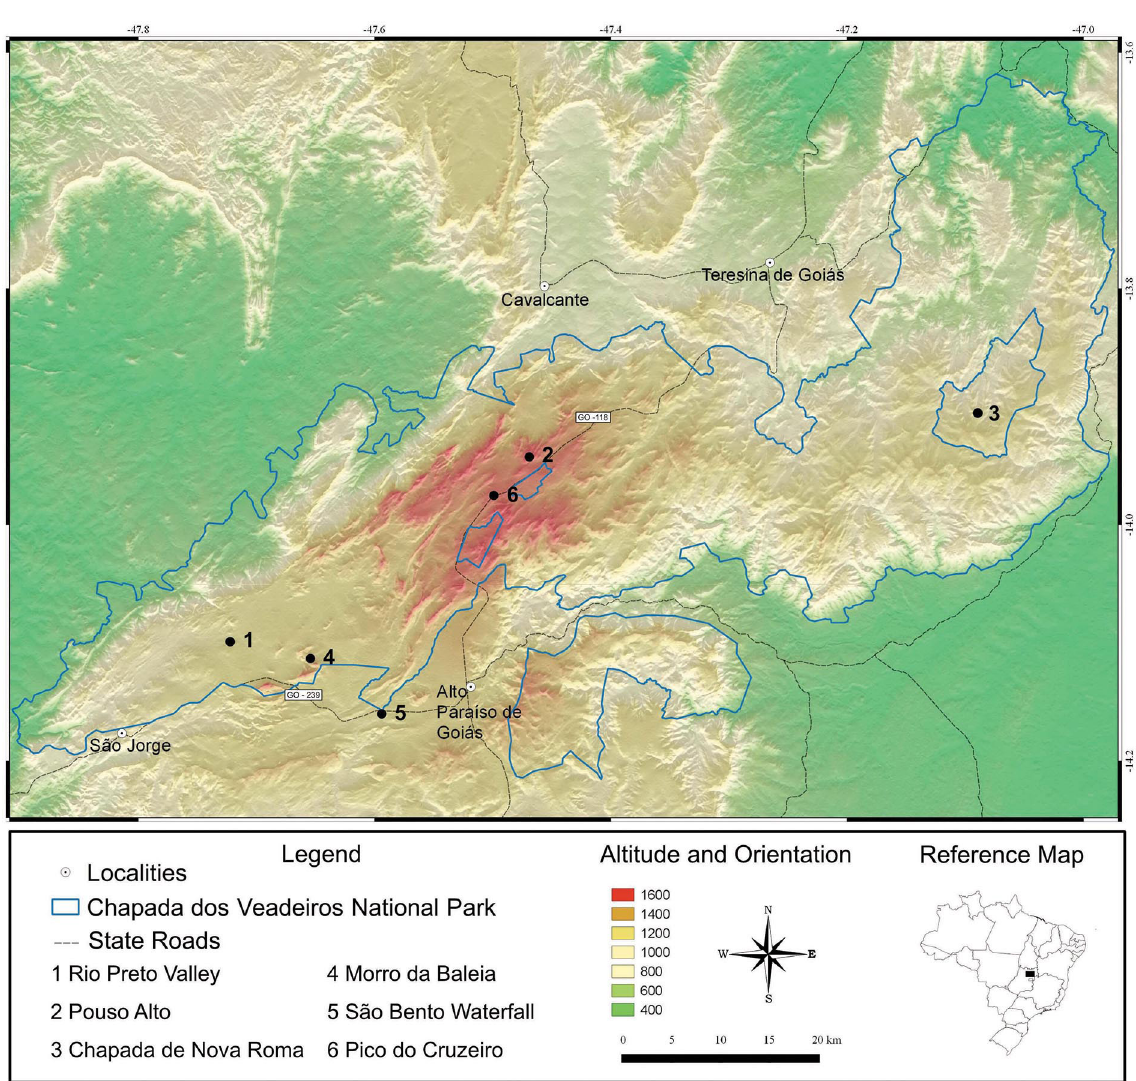
Fig. 1. The Chapada dos Veadeiros National Park: boundaries, topography, and relevant locations according to delimitation provided by Brazilian Ministry of the Environment (2017). The small blue areas enclosed in the Chapada dos Veadeiros National Park boundaries are two conservation units prior to the recent park expansion and one area designated to host a transmission